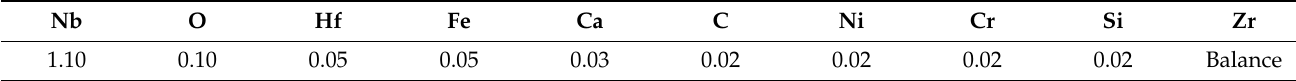
Table 1. Chemical composition of Zr-1Nb alloy